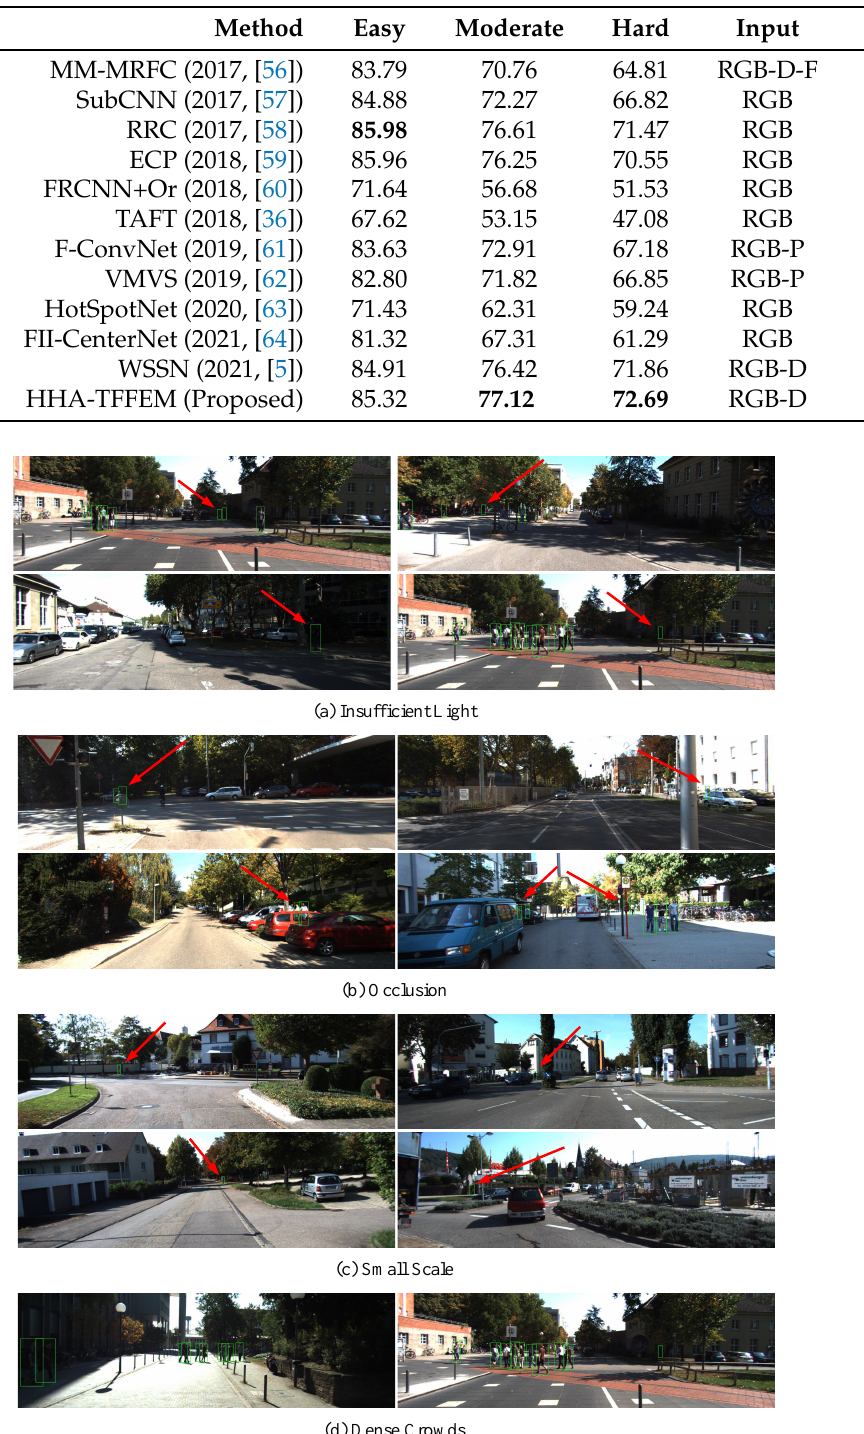
Figure 9. Visualization of our proposed detection result in some challenging scenarios on the KITTI test